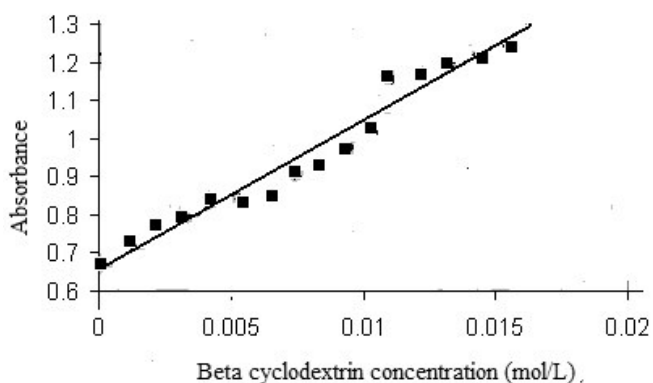
Figure 4. Observed linear absorption diagram of inclusion complexation of beta cyclodextrin and imipramine hydrochloride at pH 7.0 and maximum absorption wavelength